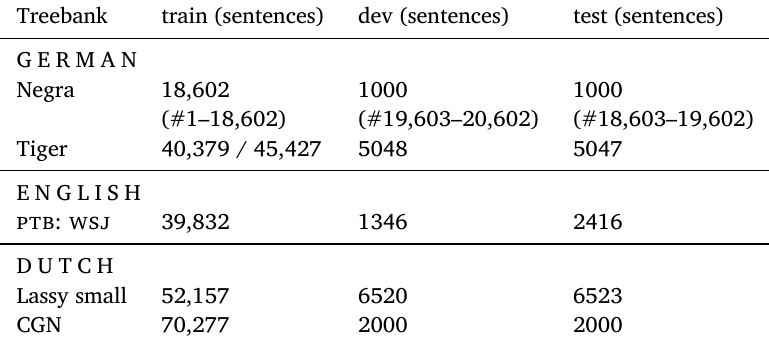
Table 1: The discontinuous treebanks used in the experiments and the number of sentences used for development, training, and testing Treebank train (sentences) dev (sentences) test (sentences) G E R M A